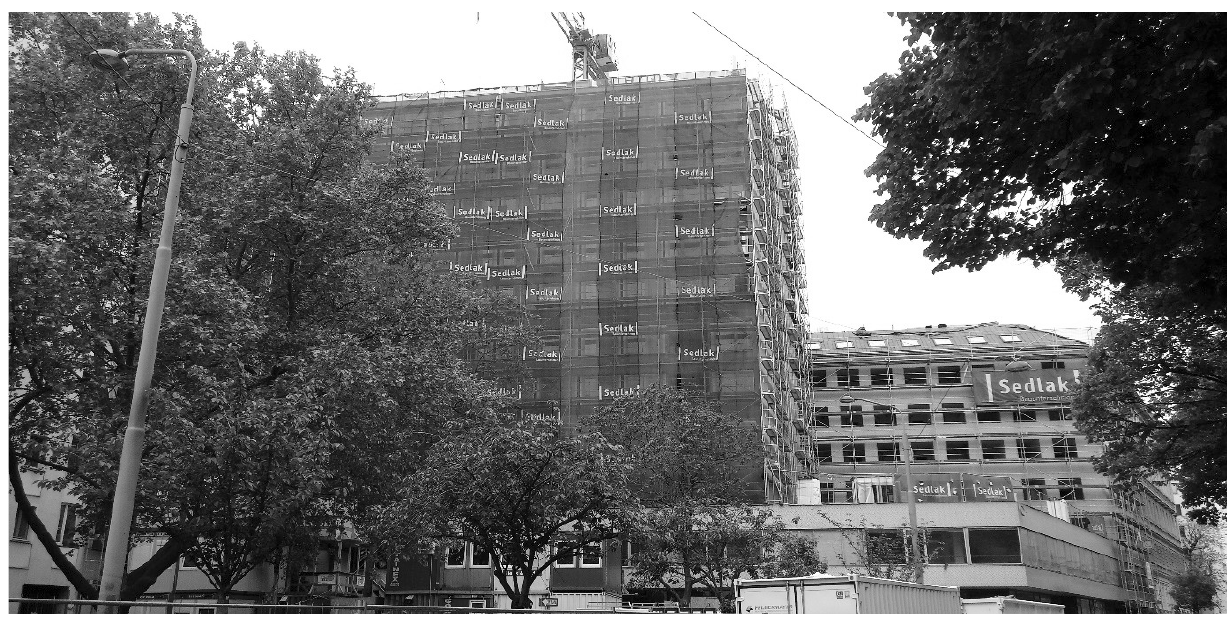
Figure 4. Traditional centrally located NP student accommodation from the 1970s under renovation. Source: Photograph taken by Elisabeth Gruber,